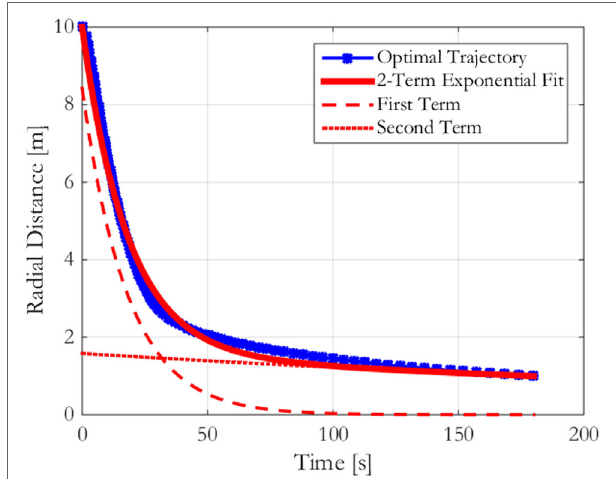
FigUre 7 | Comparison between the optimal trajectory and the optimal two-term exponential trajectory with its two component terms for a flat spin at 5 deg/s from 10 to 1 m in 180 s.